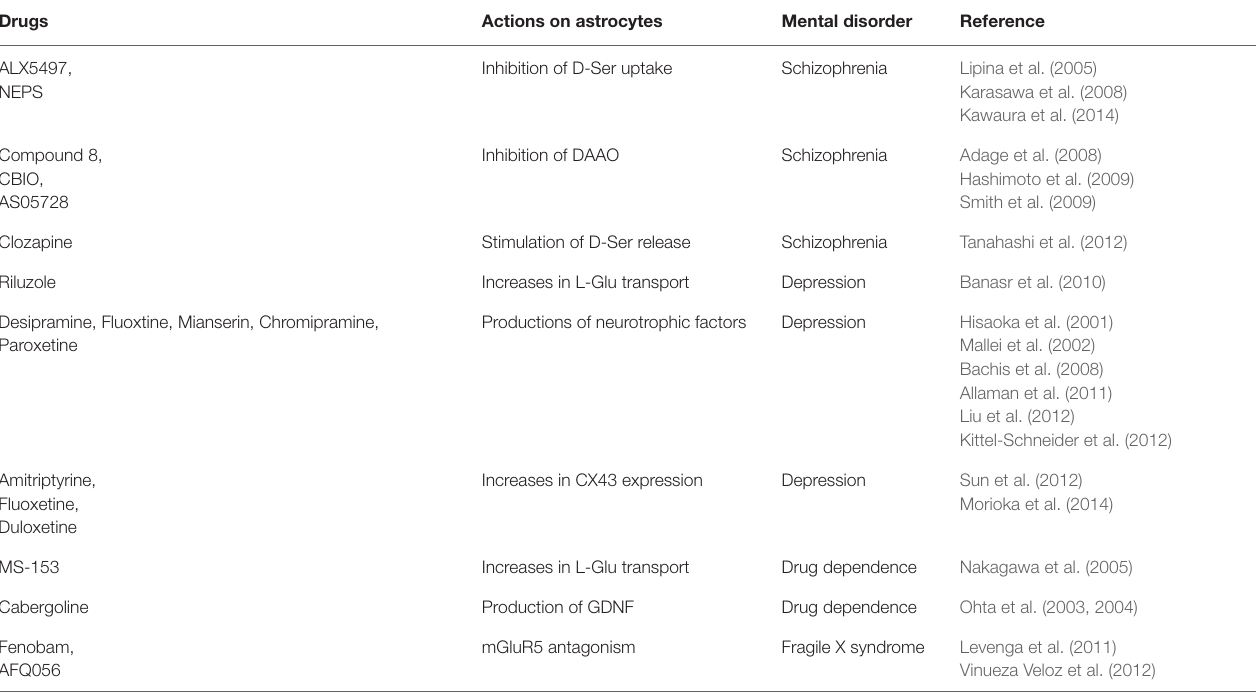
TABLE 1 | Drugs showing therapeutic effects on mental disorders by modulation of astrocytic